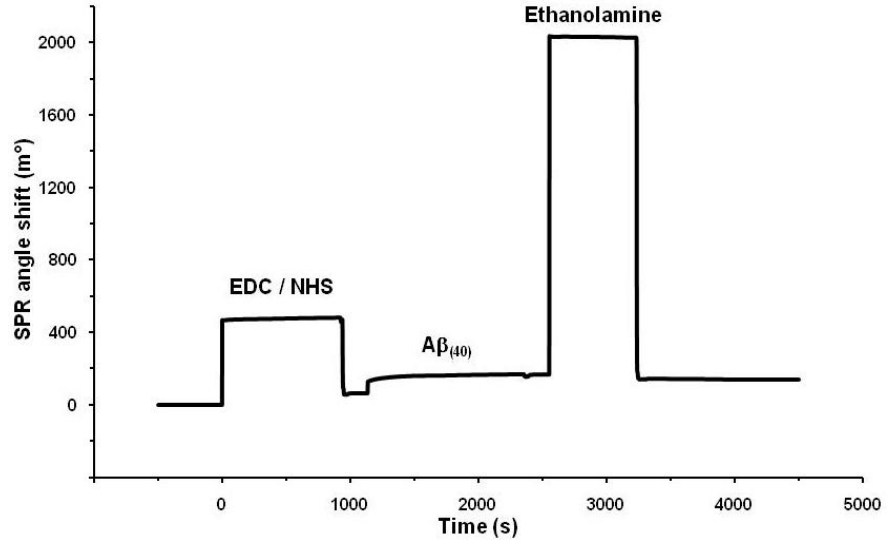
Figure 3. SPR binding curve for Aβ disc (For measurement details, see Experimental part